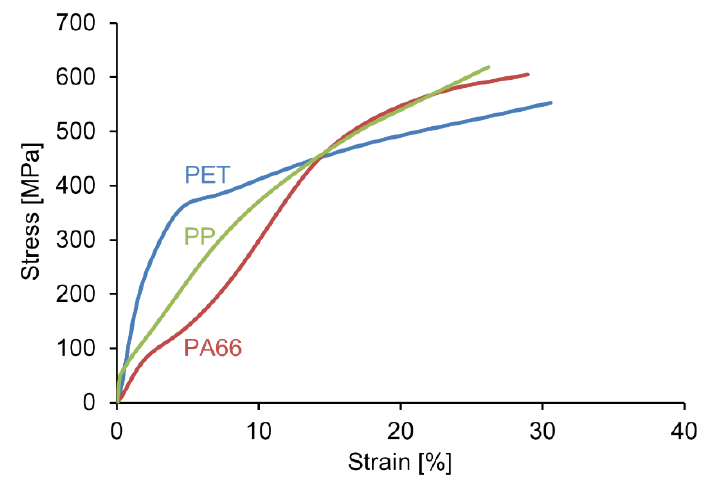
Figure 8. Typicalstress-straincurves(ownunpublisheddata)ofcommonmelt-spunmonofilaments(PA6.6, Figure 8. Typical stress-strain curves (own unpublished data) of common melt-spun monofilaments PP and PET, all diameter 80 µ m). (PA 6.6, PP and PET, all diameter 80 µm). Table 4. Physical properties of PET filaments as a function of spinning speed (one-step process)